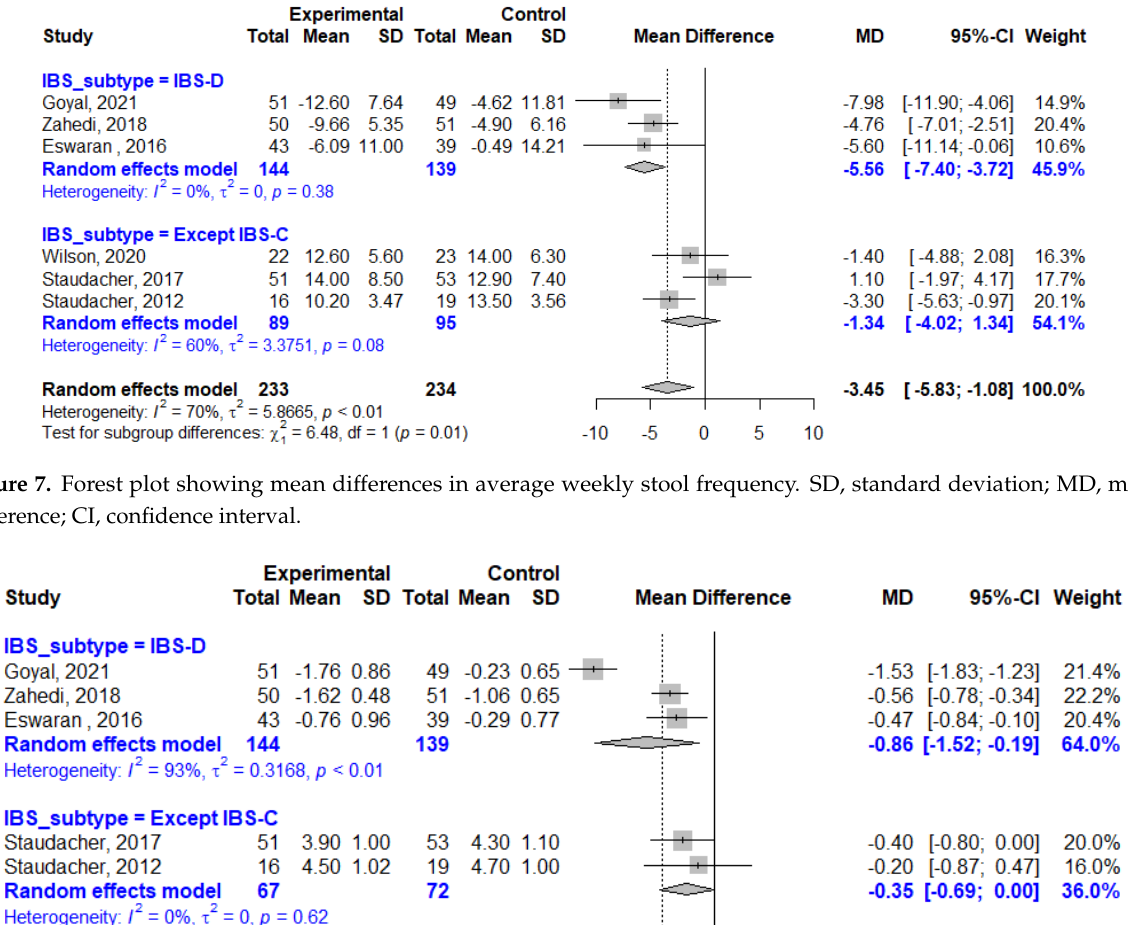
Figure 6. Forest plot showing standardized mean differences in IBS ‐ QoL. SD, standard deviation; SMD, standardized mean difference; CI, confidence interval .